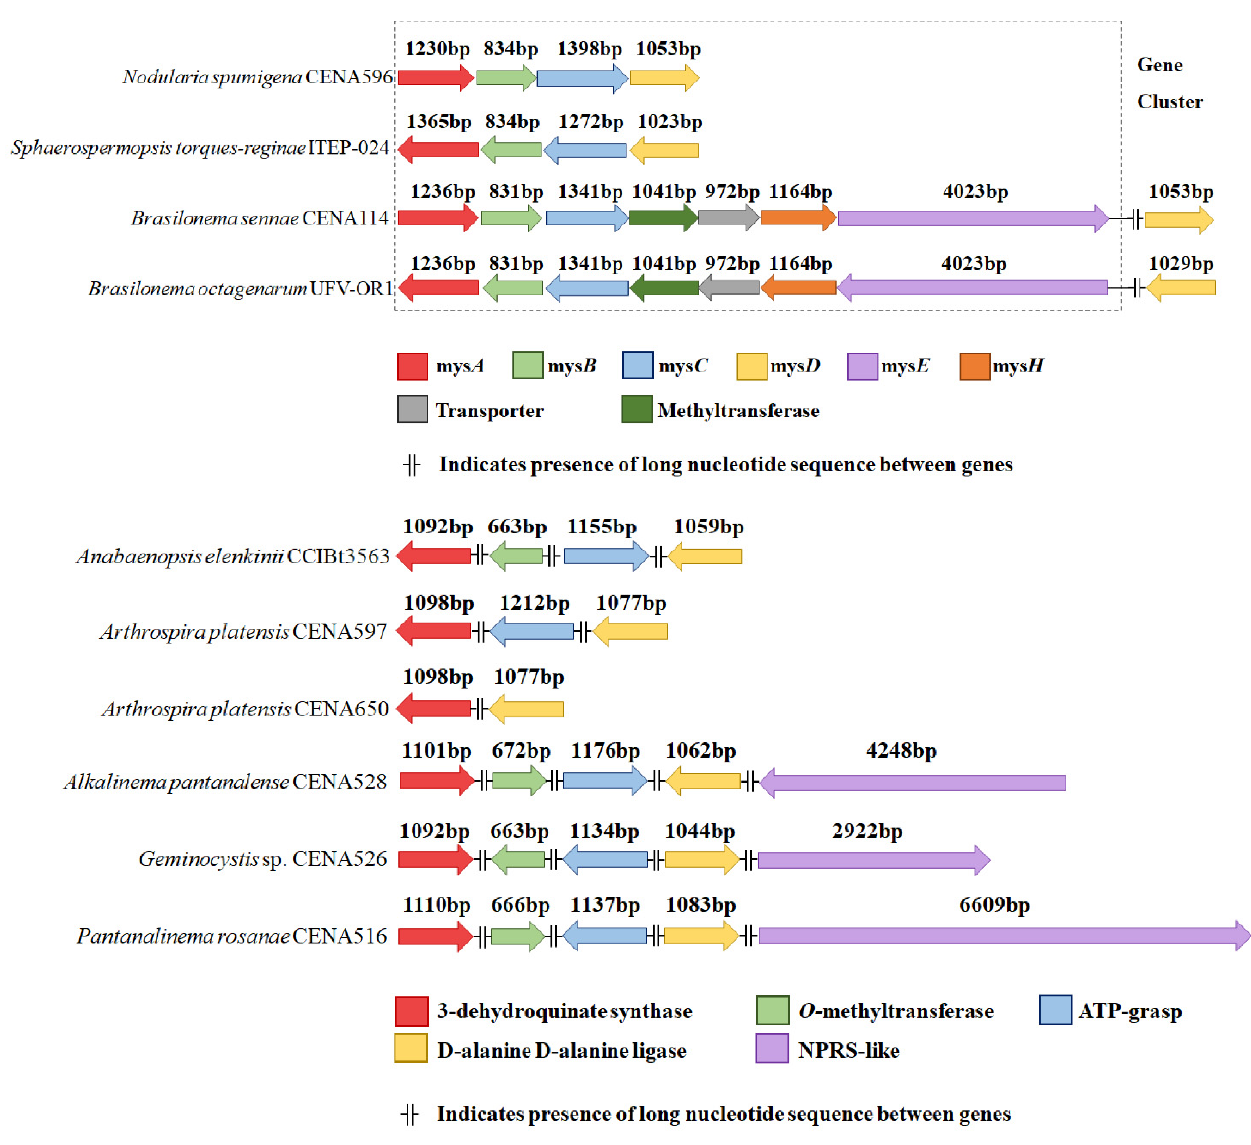
Figure 1. Genes identi fi ed at the draft genomes of each strain studied, indicating the size of each fragment (in base pairs) and the 5 ′ → 3 ′ direction according to each gene orientation. The genes identi fi ed outside a co-linear cluster arrangement are identi fi ed by the expected encoded protein. Materials, Tables